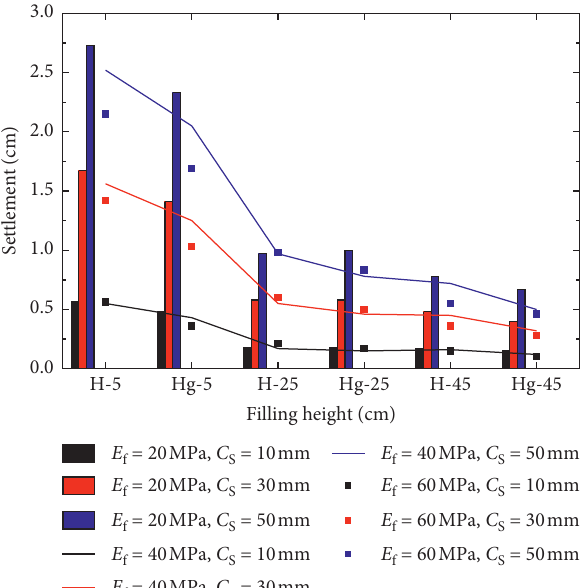
Figure 19: Variation of the settlement with different consolidation